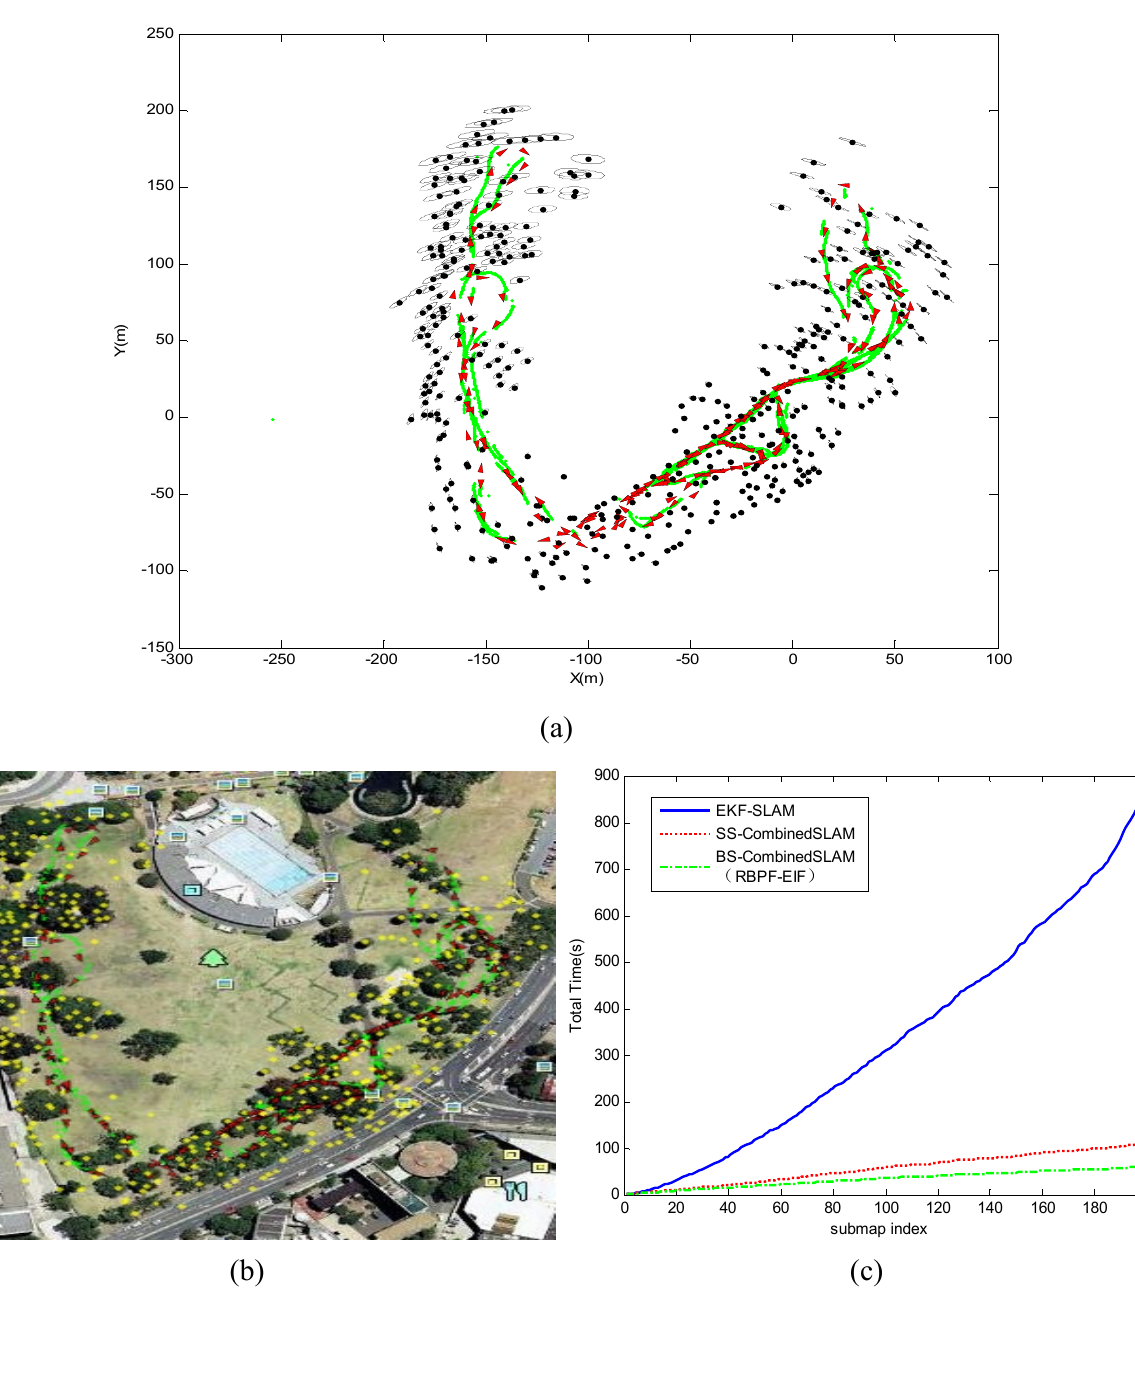
Figure 10. Results for the Victoria Park dataset. (a) Estimated map for the Victoria Park dataset (vehicle locations are drawn as red triangles, features are shown as black dots with ellipse covariance, and Green points are GPS readings). (b) Estimated results by the proposed algorithm were projected on Google Earth in order to compare the accuracy obtained (vehicle locations are drawn as red triangles, features are shown as yellow dots, and Green points are GPS readings). (c) Computational time of execution for the Victoria Park data: conventional single-map-type EKF-SLAM (blue), sequential submap-type Combined SLAM (red) and binary-tree-based submap-type Combined SLAM